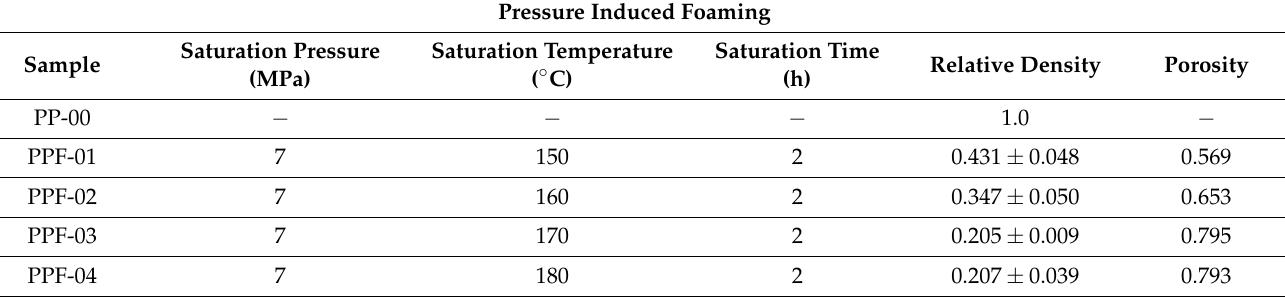
Table 1. Pressure induced in industrial rubber.